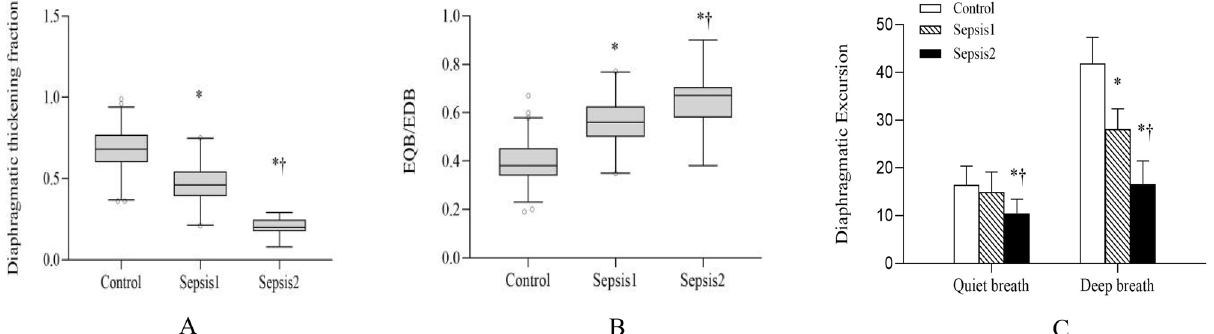
Figure 2. Diaphragmatic thickening fraction ( A ), EQB/EDB ( B ), excursion during quiet breathing and deep breathing ( C ). * P < 0.05 compared with control group; † P < 0.05 compared with sepsis group 1.